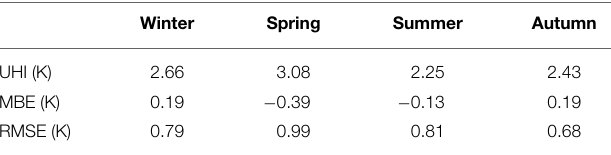
FIGURE 10 | Localization of the operation weather station for the model validation. The blue dots represent the station required to calculate the countryside temperature. The red dots are the station needed for the validation of the UHI in the city.